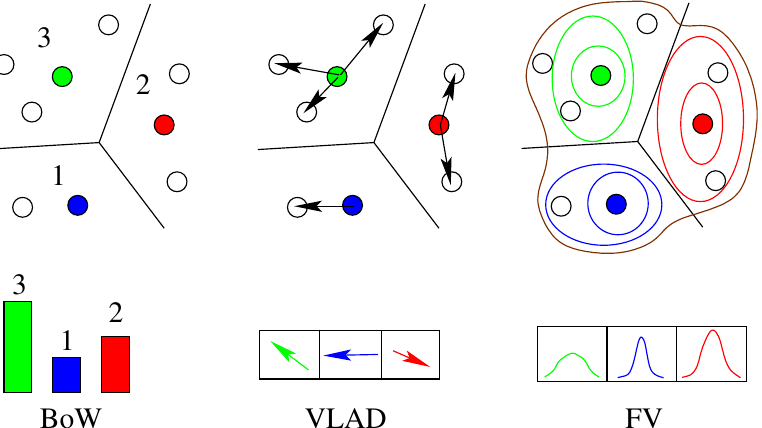
Figure 11. Comparison of three texture feature encoding methods: BoW counts the number of local features assigned to each codeword (zero order statistics of the distribution), VLAD computes the mean of feature vectors assigned to each codeword (first order statistic), while FV encodes first and second order